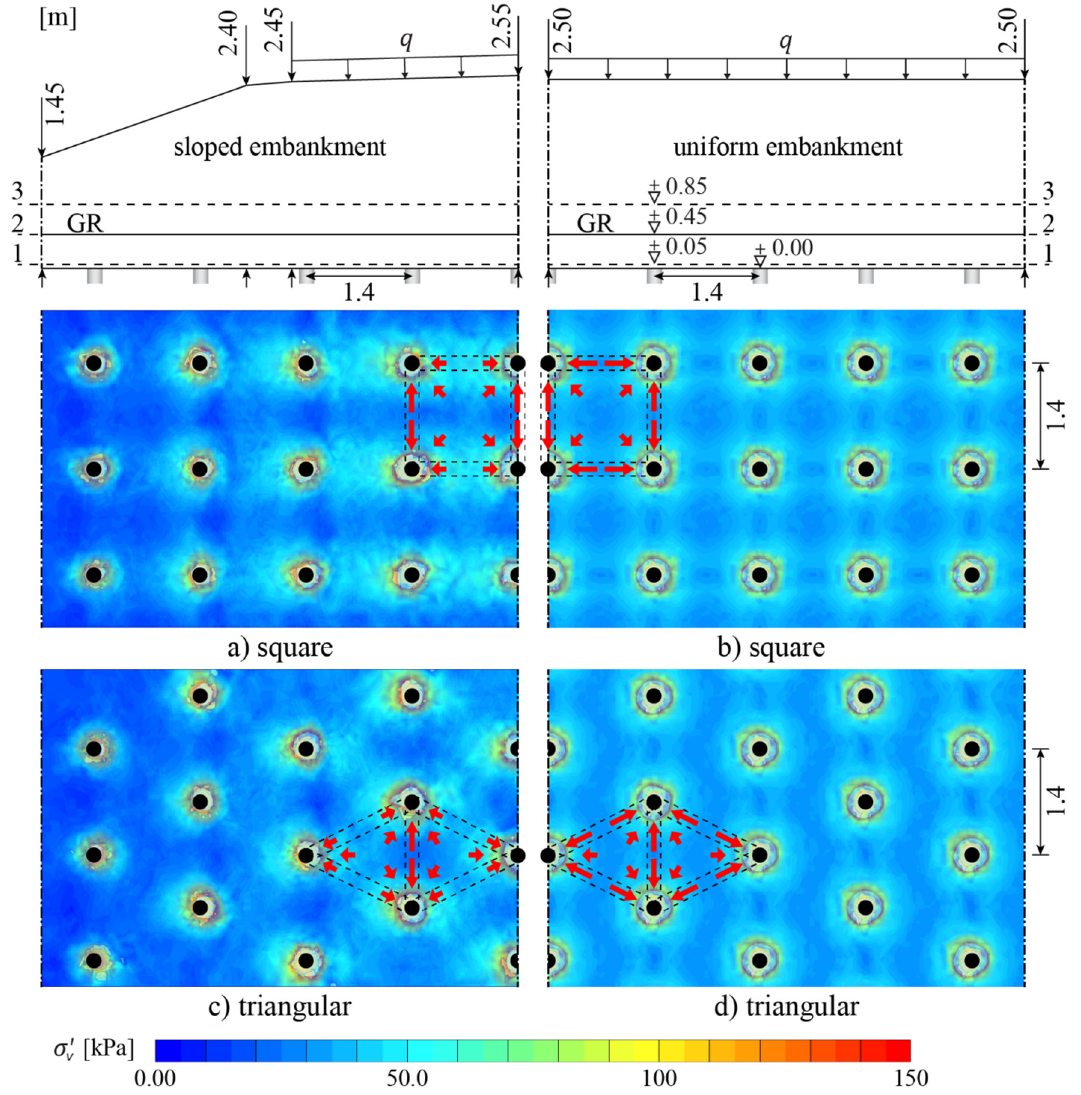
Figure 11. Distribution of vertical effective stress ( 𝜎 𝘷(cid:4593) ), as average values in the horizontal planes 1–3, in a pile group with square ( a , b ) and triangular ( c , d ) pile arrangement, with 𝑠 = 1.4 m for a sloped embankment ( a , c ) and an embankment with a uniform height of 2.50 m ( b , d ). The red arrows are the illustrative direction and magnitude of the major principal effective stress ( 𝜎 (cid:2869)(cid:4593) ) vectors. The cross-section of the sloped embankment shows the left half of the modelled embankment.